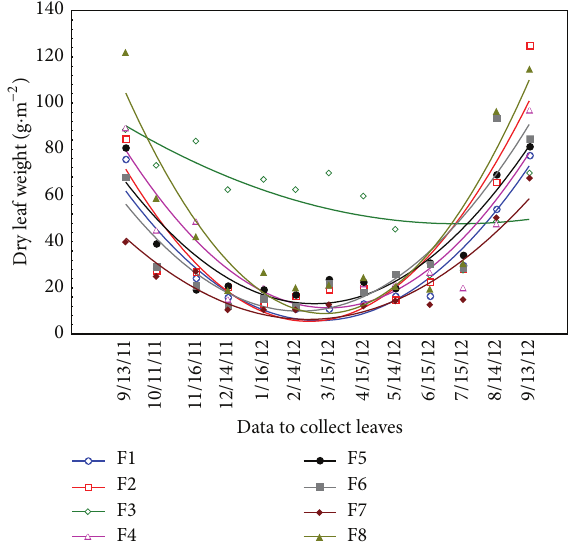
Figure 8: LAI (m 2 ⋅ m −2 ) with second-degree polynomial tendency for each fragment.